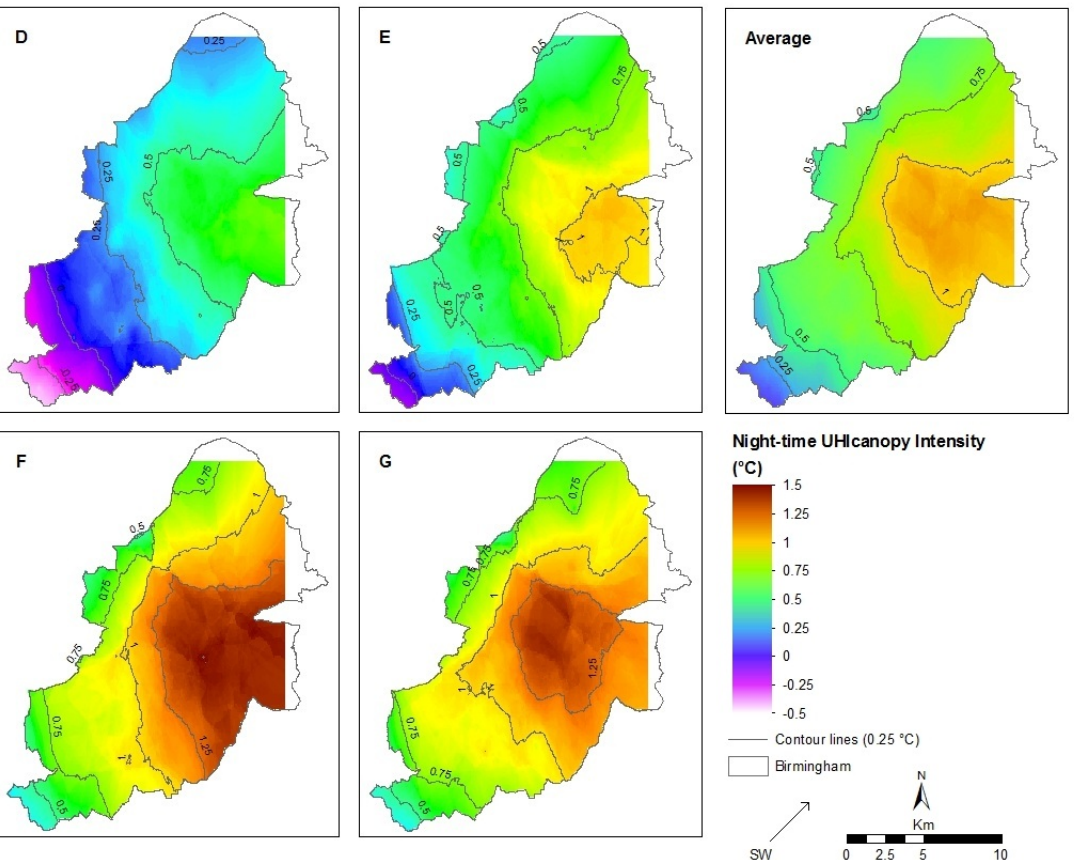
Figure 5. Night-time UHI canopy intensity, for Pasquill-Gifford Stability Classes ( D ); ( E ); ( F ) and ( G ); and Average for June, July, August 2013 and prevailing wind direction for the period. Based on the BUCL dataset.